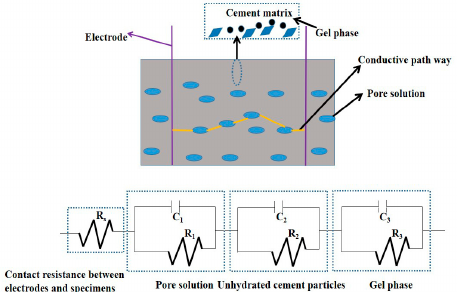
Figure 8. Corresponding equivalent circuits of cement paste with different dosages of waste fly ash.